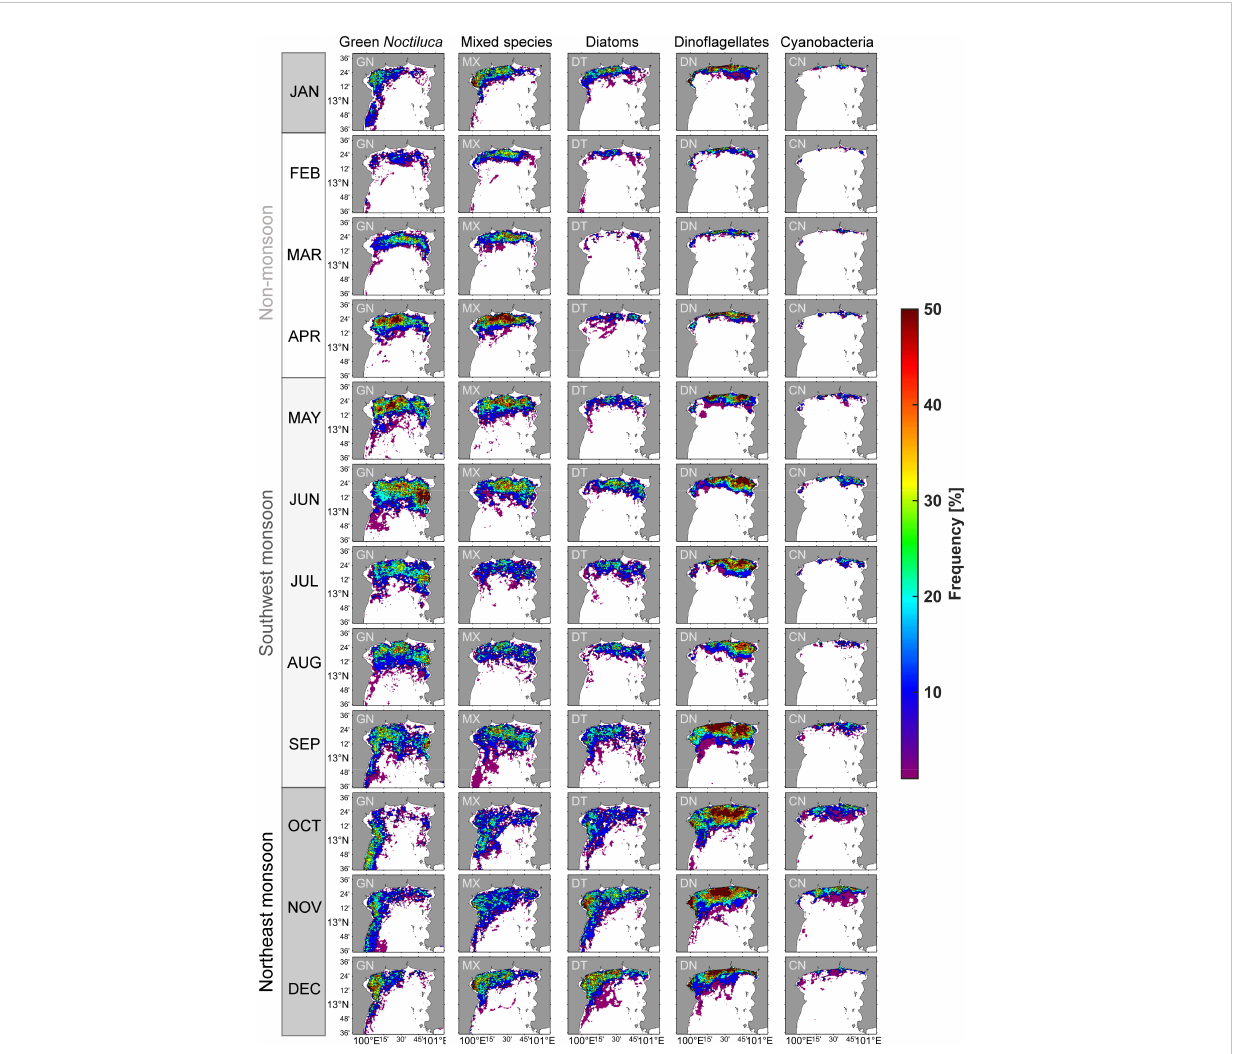
FIGURE 7 Monthly climatological distribution of the percentage bloom frequency of green Noctiluca (GN), mixed species (MX), diatom (DT), dino fl agellate (DN), and cyanobacteria (CN) blooms during 2003 – 2021. The percentage indicates the frequency of each phytoplankton bloom per data during this period. The white area had no blooms of any phytoplankton group. The minimum percentage was 5% (two times in 30